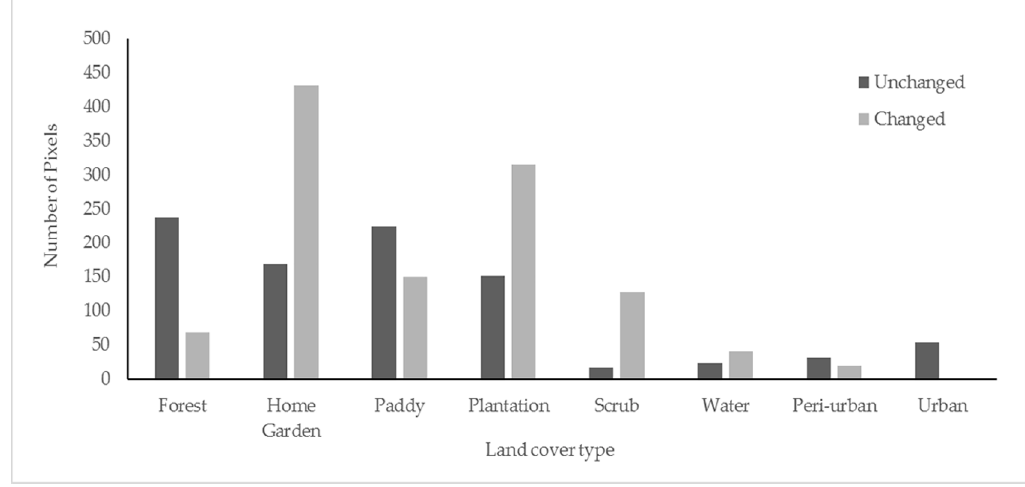
Figure 5. Summary of reference pixels (2117) that experienced land cover change over the 1988 to